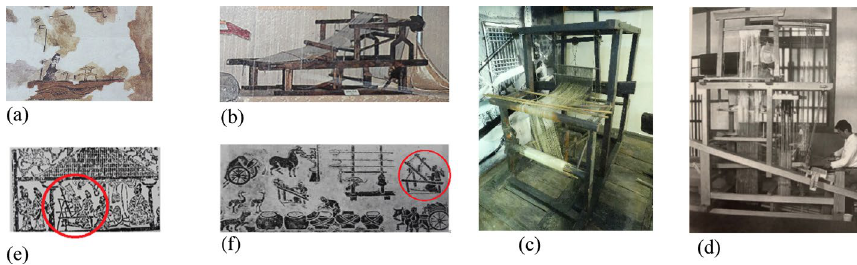
Fig. 3 Types of loom according to their structure and shape. a JikNyeo‑do ( 織 女圖 ) in a wall painting of Goguryeo tomb ( 平安 南 道 龍岡郡 大安 里 #1 古 墳 ) (Kim et al., 2021). b Reproduction loom of Goguryeo waist‑type horizontal loom in Joseon JungAngYeokSa Museum of North Korea (Kim et al., 2021). c Hwa‑Jik Gi ( 華織機 ) waist loom with an upper frame in the modern period of Korea (by authors at Folklore and Natural History Museum in JeJu). d Reproduction loom of an ancient oriental loom JeHwa‑Ru ( 製華樓 ) in Nishijin Kyoto, with two operators without waist band (by authors at Nishijin in Kyoto). e Slant loom in the Portrait Stone ( 畵像石 ) of Han ( 漢 ) dynasty (Kim et al., 2021). f Diagram of oblique looms in Han dynasty (Shin, 2012) (All photos are with permission from the copyright